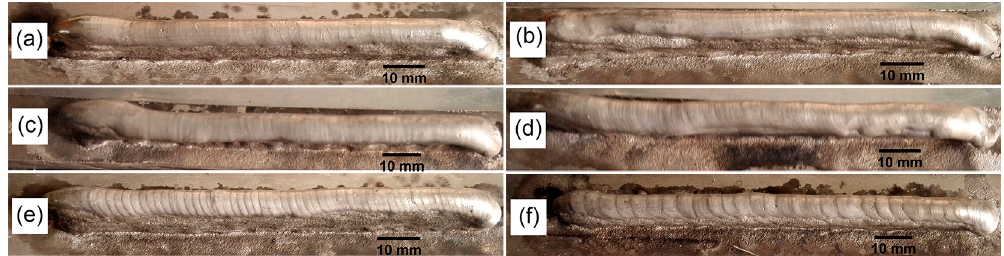
Figure 5. Surface morphologies of the samples deposited by different pulse frequencies: ( a ) 500 Hz; ( b ) 100 Hz; ( c ) 10 Hz; ( d ) 5 Hz; ( e ) 2 Hz and ( f ) 1 Hz.